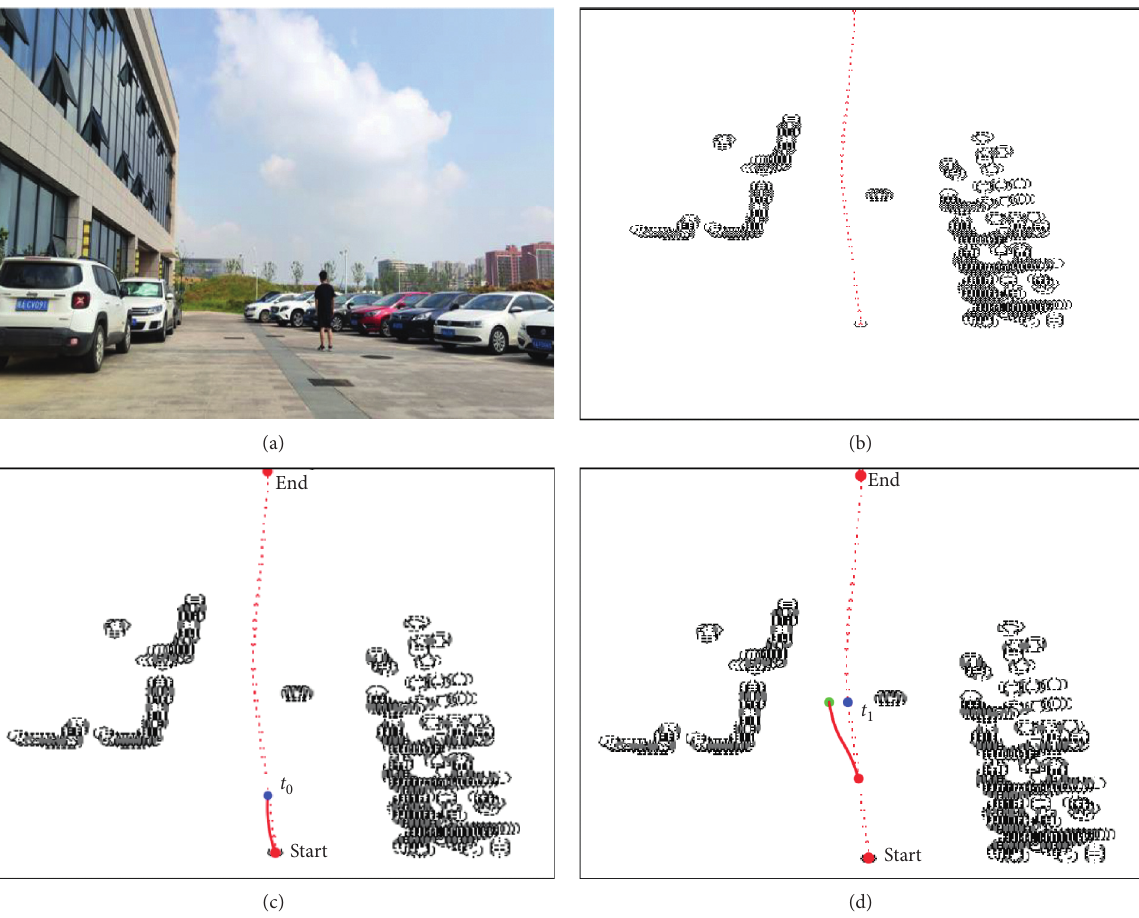
Figure 22: The results of two-layered path planning method in scenario 1. (a) The experiment scenario. (b) The improved Bi-RRTplanning result in high-level model. (c) The planning result of low-level model at time t 0 . (d) The planning result of low-level model at time t 1